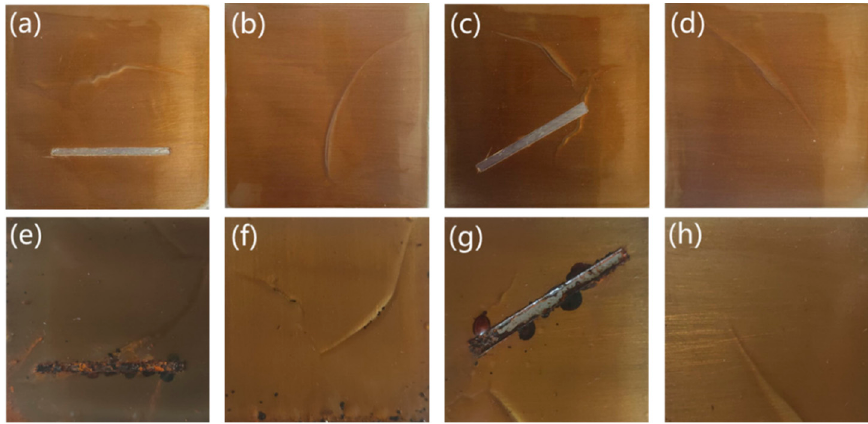
Figure 12. Salt spray photograph: ( a , b ) of conventional core-shell coating, and ( c , d ) of three-layer core–shell coating. ( a – d ) before the salt spray tests, and ( e – h ) after spraying of 400 h.